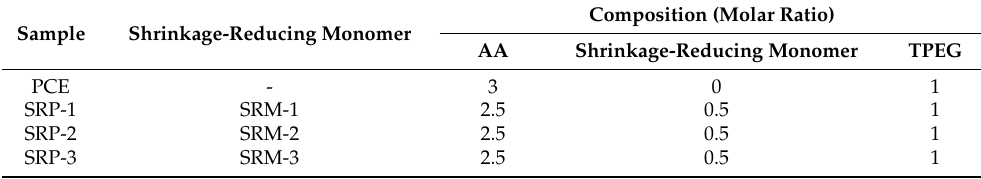
Table 2. Composition of the synthesized